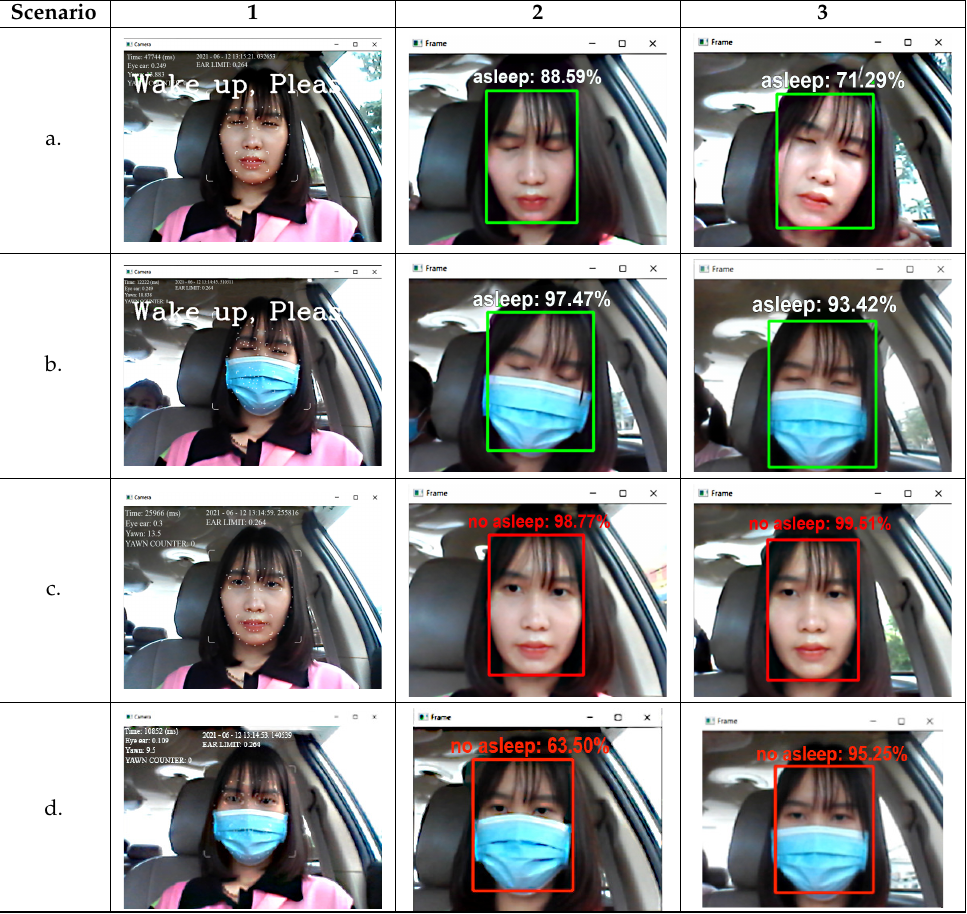
Table 8. Some experimental results of drowsiness detection for three scenarios.